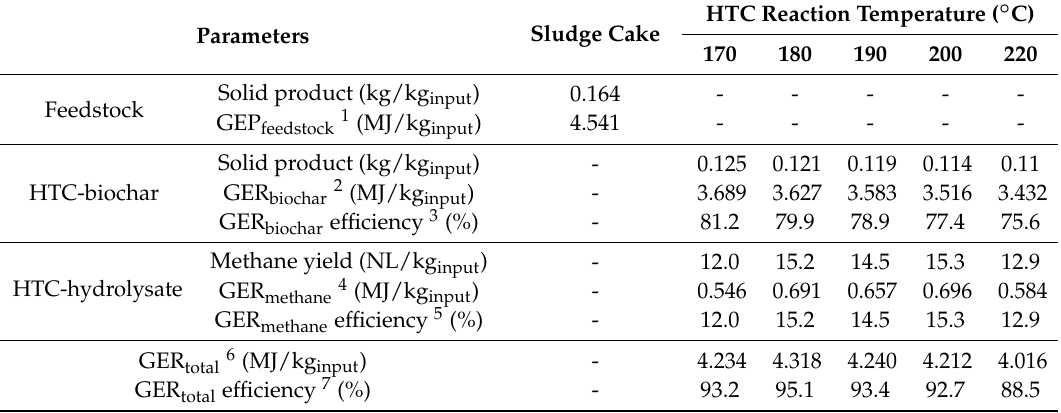
Table 6. Gross energy recovery efficiency of sludge cakes in the poultry slaughterhouse with the HTC system.